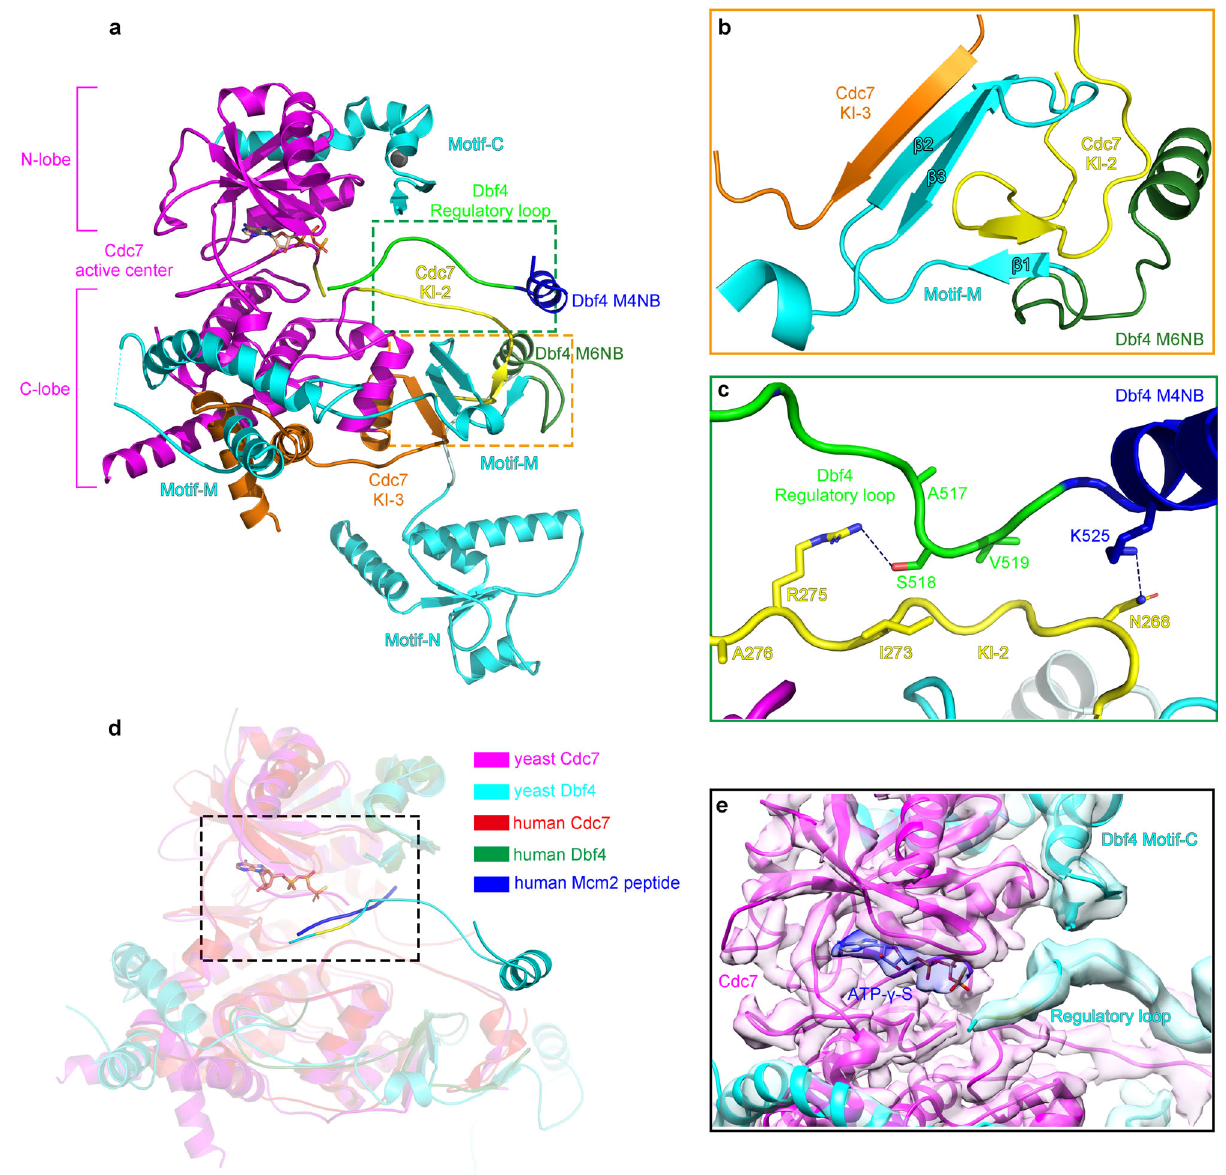
Fig. 3 Structural features of the kinase core of DDK from the assembled DH-DDK. a Overview of the Dbf4-Cdc7 structure shown in a cartoon view with the motifs N, M, and C of Dbf4 in cyan, the M6NB motif of Dbf4 in forest green, the M4NB motif of Dbf4 in blue, the regulatory loop of Dbf4 in green, the canonical kinase region of Cdc7 in magenta, the kinase insertion 2 (KI-2) in yellow and 3 (KI-3) in orange. Zn atom is shown as grey sphere and nucleotide (ATP- γ -S) in stick model. b Magni fi ed view of the boxed region in a showing three β -strands ( β 1-3) from Dbf4 motif M engaging with KI-2 and KI-3 of Cdc7 to maintain these kinase insertions in stretched conformations. c Magni fi ed view of the boxed region in ( a ) highlighting the interactions between KI-2 of Cdc7 and the regulatory loop and M4NB of Dbf4. The hydrogen bonds between R275 of Cdc7 and S518 of Dbf4, N268 of Cdc7 and K525 of Dbf4 are indicated by dashed lines. d Superimposition of the yeast Dbf-Cdc7 with a truncated version of human CDC7-DBF4 in complex with an Mcm2 (residues 38 – 46) peptide substrate (PDB code 6YA7) 33 . The structures are shown in cartoon representation and color-coded as indicated. The postions of Thr506 and Ser507 residues from Dbf4 are highlighted in yellow. e Magni fi ed view of the boxed region in ( d ) but with the cryo-EM map superimposed. The γ - phosphate of the ATP- γ -S nucleotide (blue) is situated in the active center of Cdc7 and very close to the last resolved N-terminal residue of Dbf4 regulatory loop